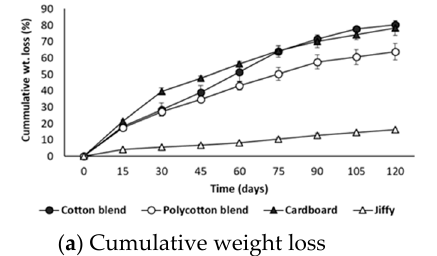
Figure 16. Soil burial test results.